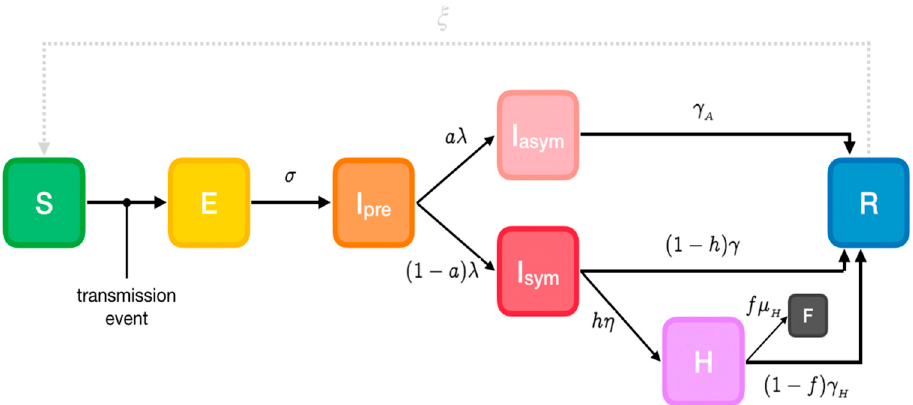
Figure 1. Phase-1 Susceptible-Exposed-Infectious-Recovered (SEIR) model. Cases are clas- sified into susceptible (S), exposed (E), infectious (I, which is divided into 3 compartments: I pre , before developing symptoms and I symp for clinically ill or I asymp for true asymptomatic), Hospitalized (H), fatalities (F) and recovered (R) (https://github.com/ryansmcgee/seir-